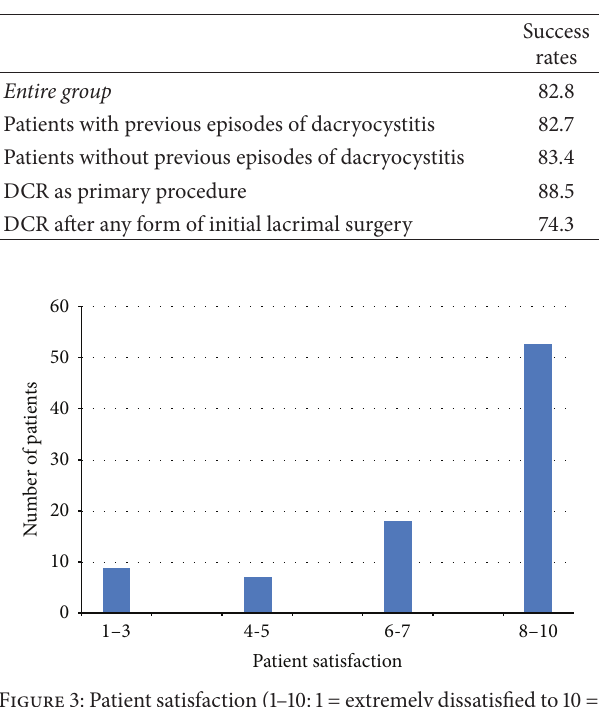
Table 2: Success rates in the entire group and different subgroups.